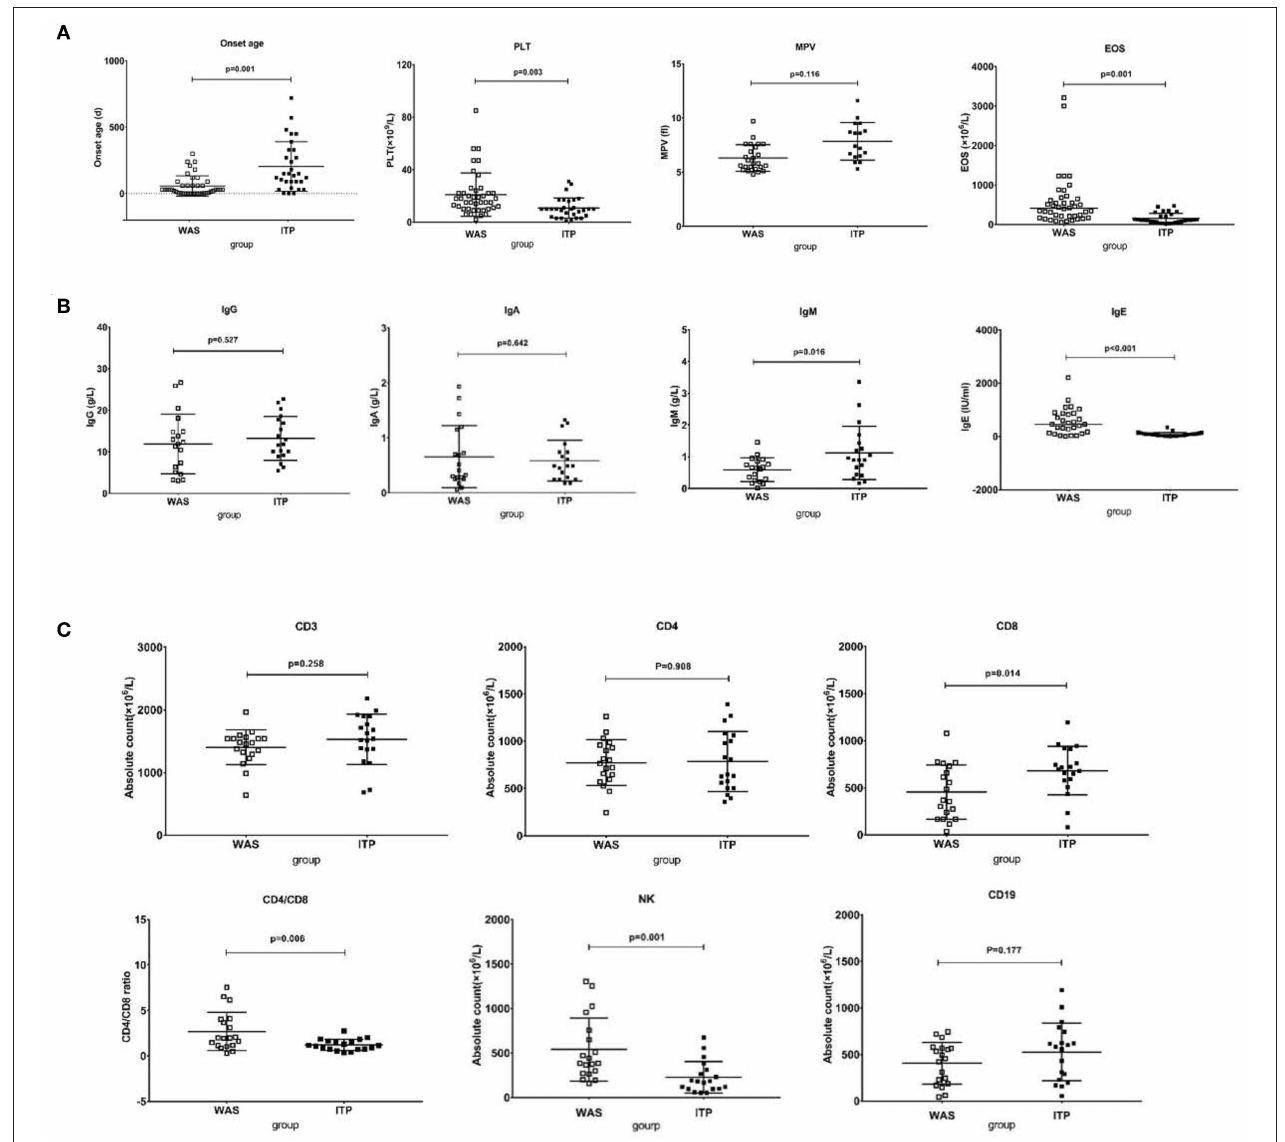
FIGURE 4 | Comparison between WAS patients and ITP patients. (A) The comparison of onset age, PLT, EOS, and MPV between the two groups. The differences in the former three were significant ( p < 0.01). (B) The comparison of IgG, IgA, IgM, and IgE between the two groups. The differences in the latter two were significant ( p < 0.05). (C) The comparison of lymphocytes subsets between the two groups. The differences in CD8 significant ( p < 0.05).